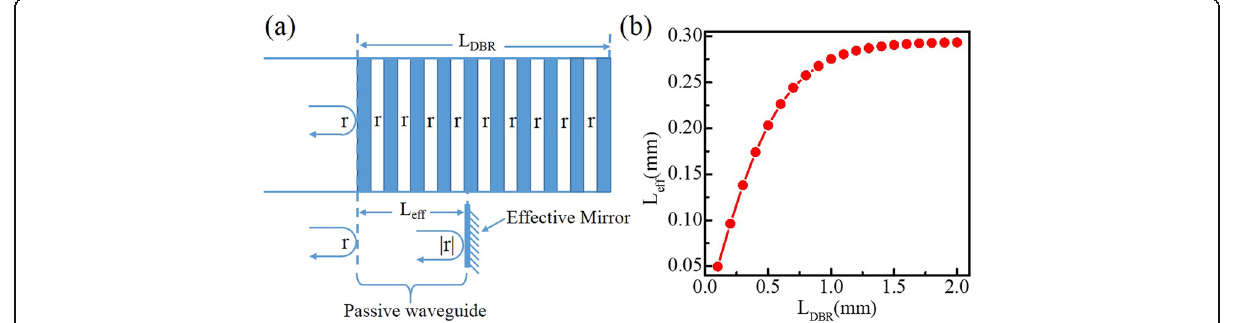
Fig. 4 a The schematic diagram of definition of an effective mirror for a DBR grating. b The effective DBR length versus the physical grating